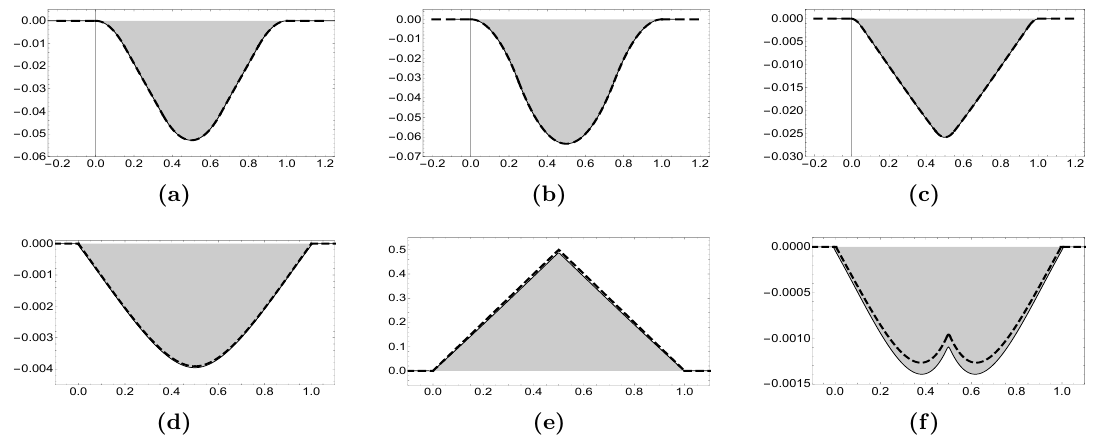
Figure 15. The numerical solutions (cid:17) ( t; x ) (shadowed region under the solid curve) and the approximated oscillon solution (dashed curve) in the perturbed model (5.6) for (cid:15) = 1 and l = 1 at (a) t = 0 : 15, (b) t = 0 : 25, (c) t = 0 : 45, (d) t = 0 : 5. (e) The derivative @ t (cid:17) at t = 0 : 5. (f) The solution at t = 0 : 5059.